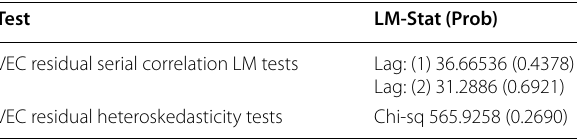
Table 4 Diagnostic test